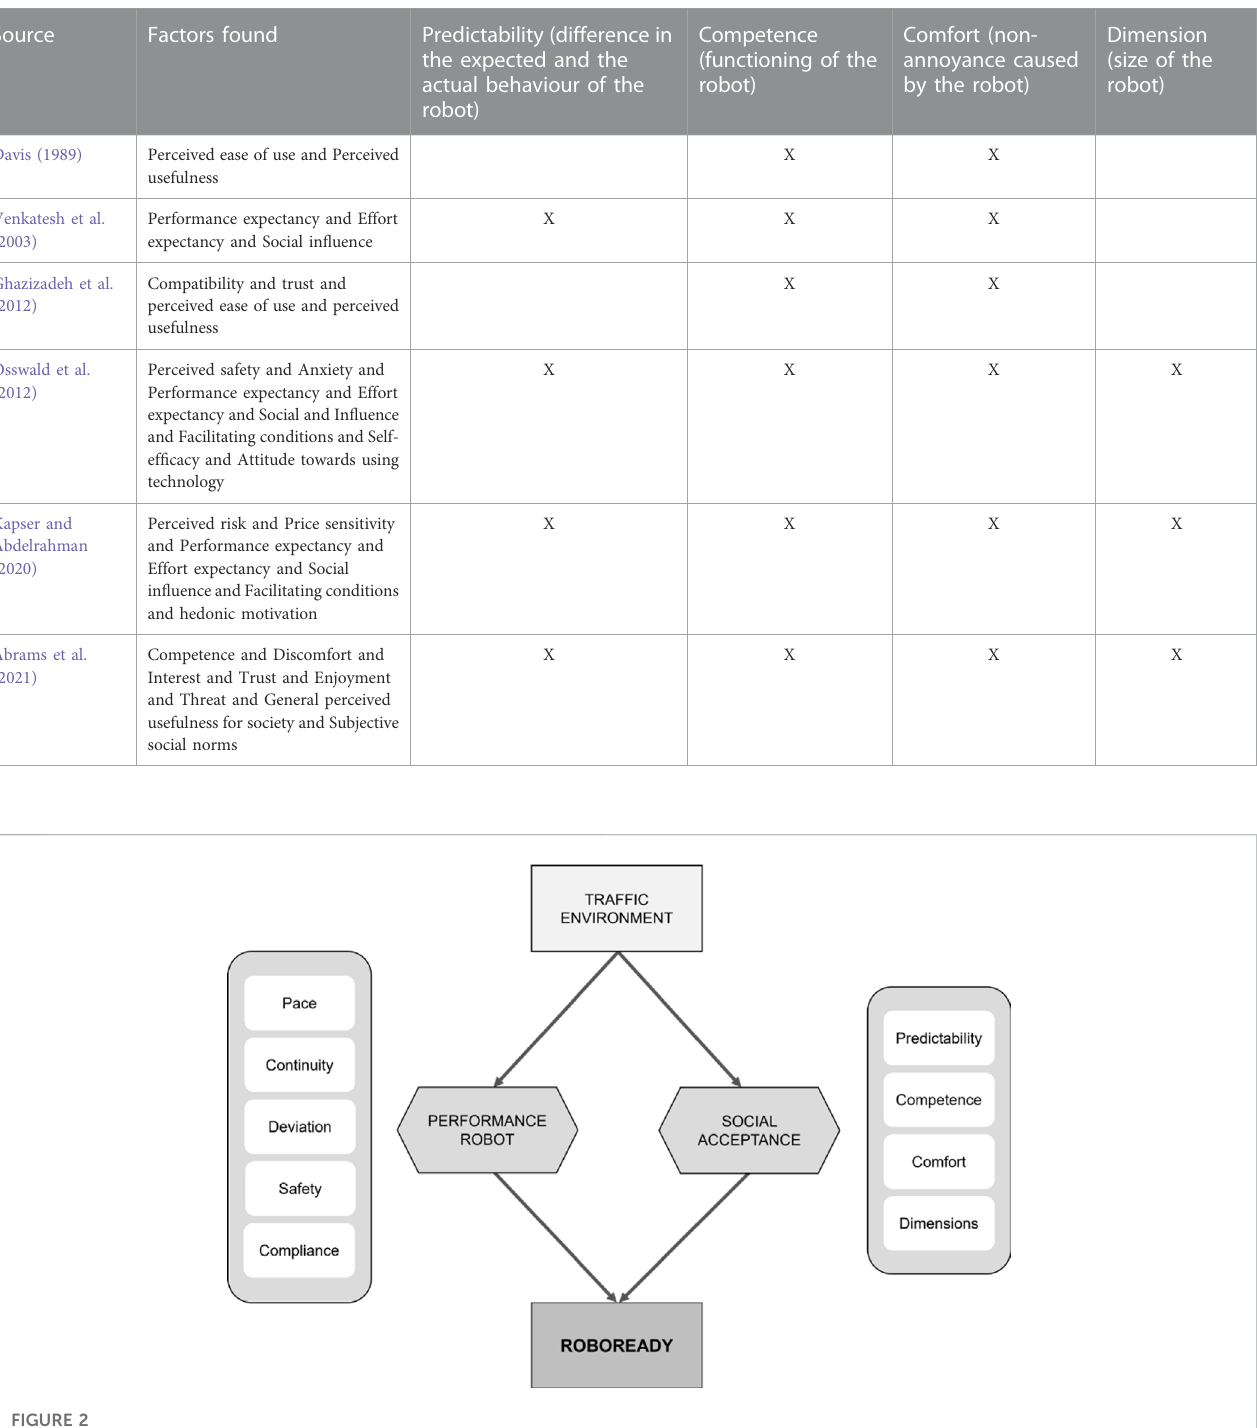
TABLE 2 Acceptance factors derived from literature review.